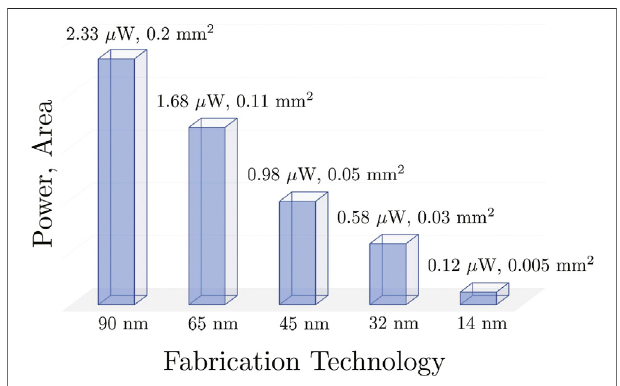
FIGURE 9 | Power consumption and footprint scaling of asingle FSM to more advanced fabrication